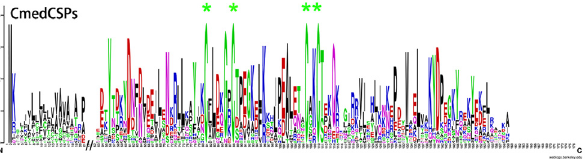
Fig 6. CmedCSPs sequence logo. Degree of amino acid sequence conservation along the primary sequence axis of C . medinalis chemosensory proteins (CSPs). Depicted amino acid character size correlates to relative conservation across aligned sequences. Green asterisks indicate the conserved four cysteine motifs characteristic of CSPs.